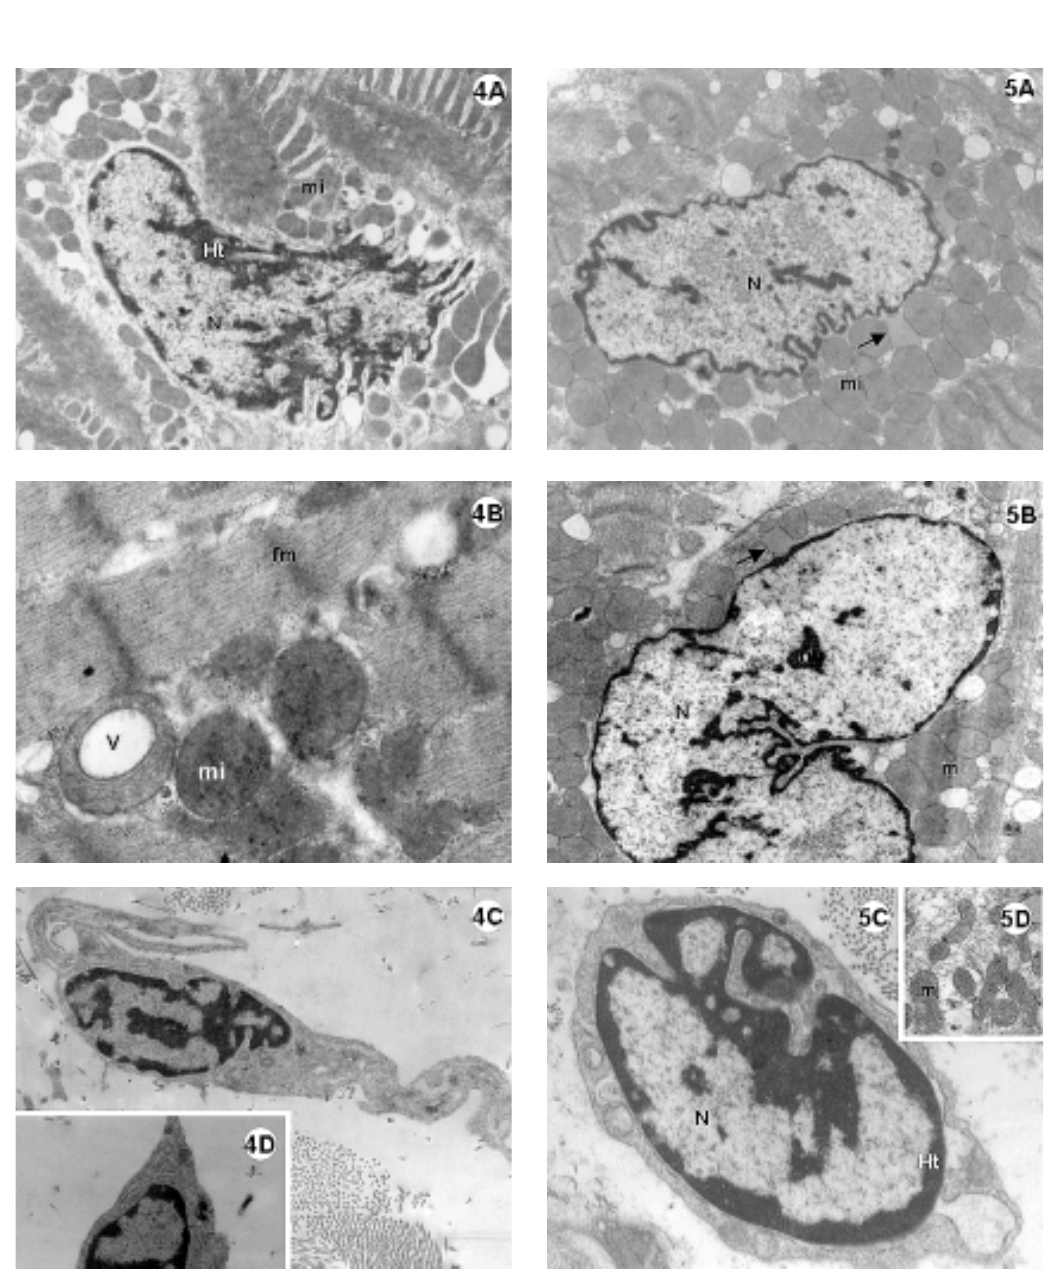
Fig. 4-5 - Electronic photomicrography of the lateral wall of the left ventricle of the rabbit heart submitted to the Langendorff System. 4A-D: Experimental group I; hearts submitted to cardiac arrest protected with low-volume cardioplegic solution (LVCS). The nucleus of the cardiac muscle cell with marginalization and thickness of the heterochromatin (ht) dispersed in masses within the nucleus (N). Mitochondria (mi) seen with an elongated shape and disorganized crests. Evidence of the loss of striation pattern of the muscle fiber with hyper-contraction. B. Details of the presence of vacuole (V) within the mitochondria and between the striated fibers (fm). C. Fibroblast and band of collagen. D. Details showing the lack of rough endoplasmic reticulum. Magnification: 4A = 11600 x; 4B = 25000 x; 4C = 9000 x; 4D = 7700 x 5A-D: Experimental group II; hearts submitted to cardiac arrest protected with LVCS followed by perfusion with Ringer Locke solution. A and B: Nuclei (N) of the cardiac muscle cells with marginalization of the heterochromatin (ht); Chromatin apparently diffuse (cr); Nucleoli evident and compacted (nu); mitochondria with condensed crests (mi); granules of lipids around the nucleus (arrows). C. Fibroblast with a lack of rough endoplasmic reticulum. N = nucleus. D. Details of the electrodense mitochondria. Magnification: 5A and 5B = 11600 x; 5C = 19300 x; 5D = 9000